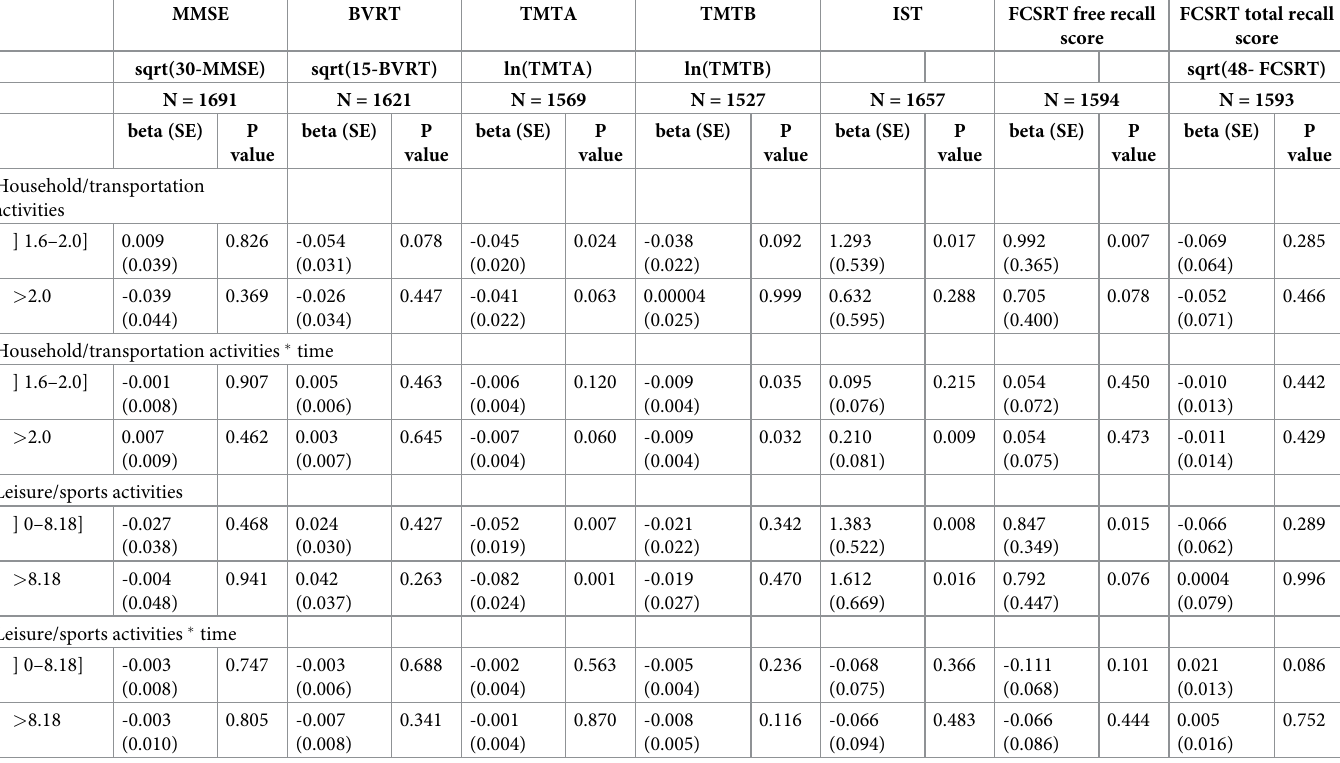
Table 3. Associations of physical activity with cognitive changes (multi-adjusted model �